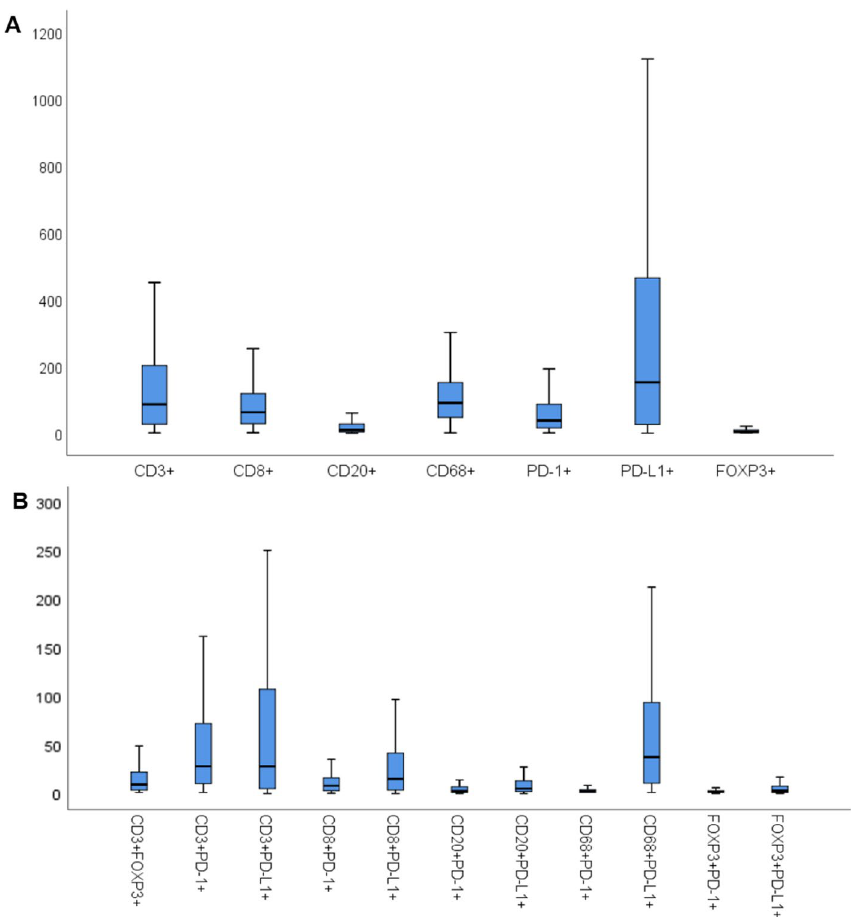
Figure 2. Box plots of key investigated stromal immune cell counts per TMA tissue core (cells/1.13 mm 2 ) for single markers ( A ) and double markers ( B ). Outliers were